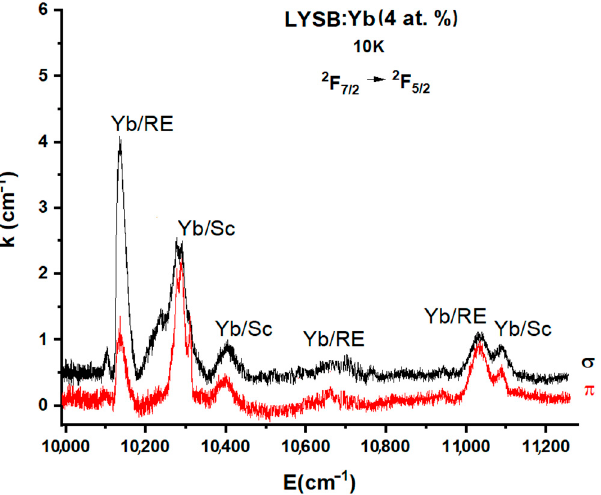
Figure 22. Low ‐ temperature (10 K) absorption spectra in polarized light of LYSB:Yb (4 at.%) crystal. Yb/RE and Yb/Sc denote the absorption lines of Yb 3+ ions associated with Yb 3+ in the position of RE 3+ (RE = La, Y) or Sc 3+ , respectively. Reprinted with permission from ref. [44], copyright 2020, Elsevier.